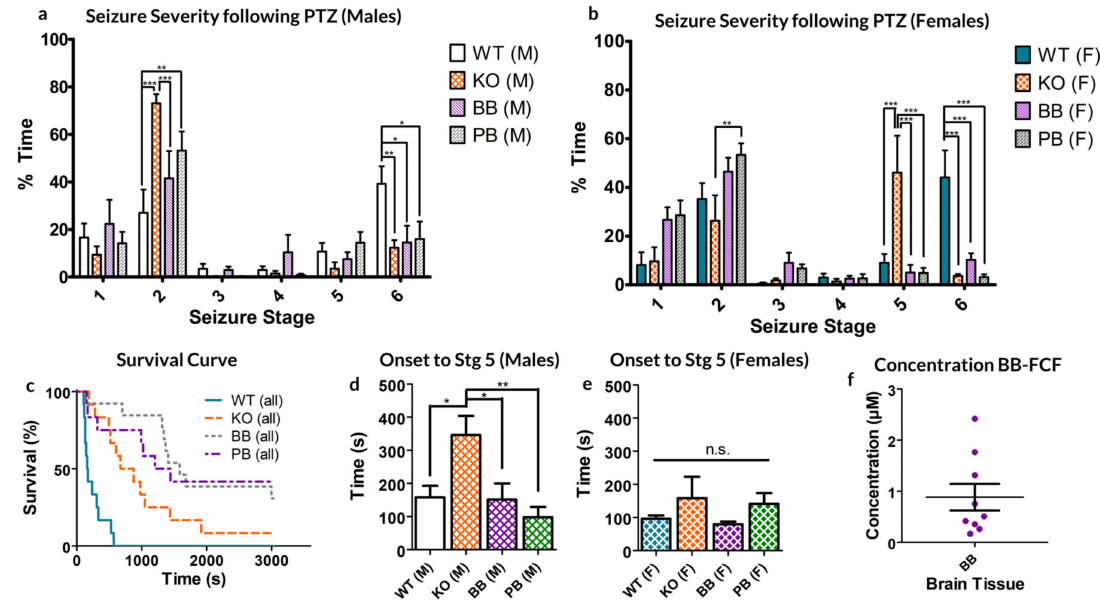
Figure 1. Response to 80 mg / kg pentylenetetrazol (PTZ) injection in each of the four animal groups, WT (normal pannexin-1 expression), KO (genetic knockout of pannexin-1) and WT-treated BB (pretreated with Brilliant Blue-FCF) or PB (pretreated with probenecid) mice. ( a , b ) male and female (respectively) mice demonstrated altered distributions of time spent manifesting behaviors of di ff erent seizure stages. ( c ) Survival curve of both sexes of animals following PTZ injection. ( d , e ) Average time to first stage 5 seizure. No significant di ff erences exist between the two sexes of the same experimental group. KO Males took significantly longer to reach stage 5 seizures than any other group except KO females. ( f ) The average concentration of BB-FCF, as measured through spectrophotometry of homogenized brain tissue, was approximately 0.88 ± 0.26 µ M. In all cases, * p < 0.05, ** p < 0.01, *** p < 0.001,